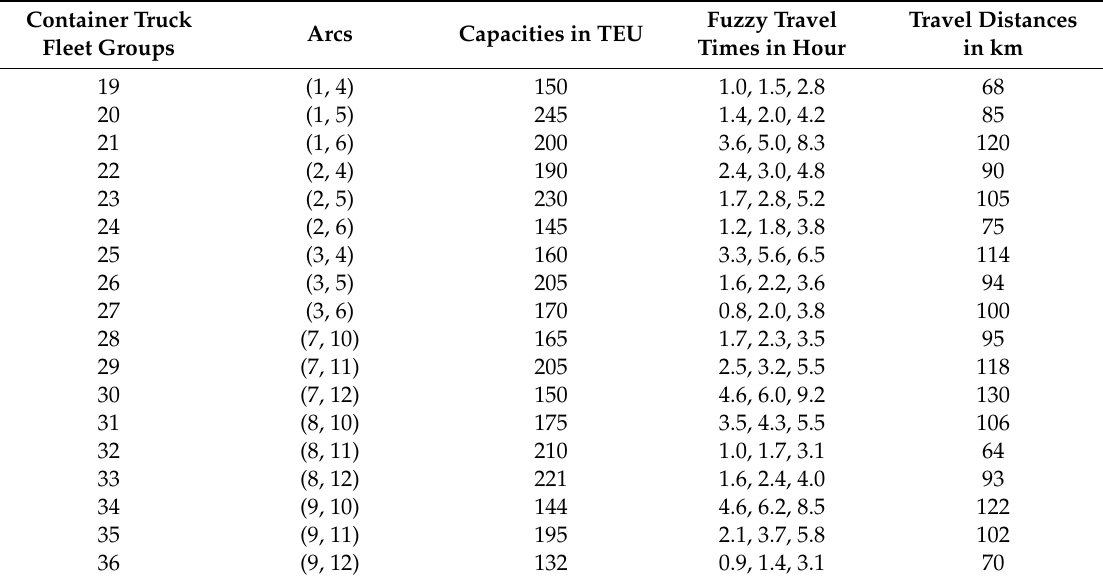
Table A2. The capacities, travel times, and travel costs of the container truck fleet groups in the network.